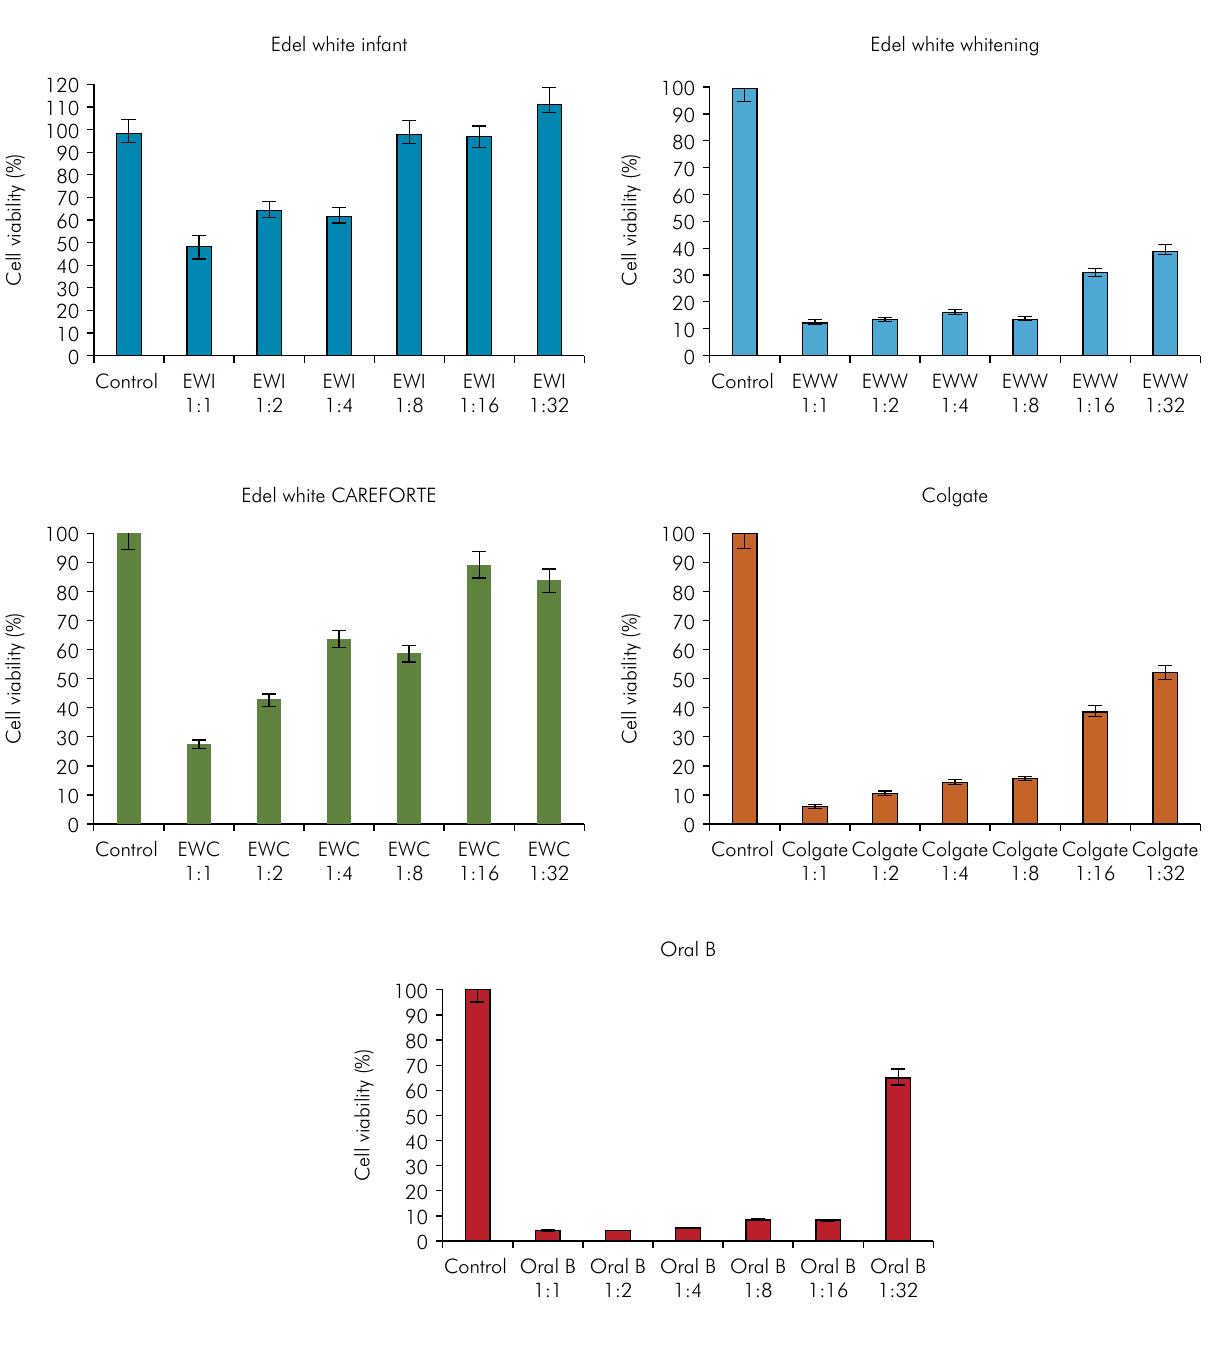
Figure 1. Cytotoxicity of toothpastes in hGF after exposure to solutions. Original solutions (1:1) were serially diluted with cell culture medium as indicated. Bars represent medians plus 25th and 75th percentiles. Statistically significant differences between untreated and treated cell cultures are indicated by